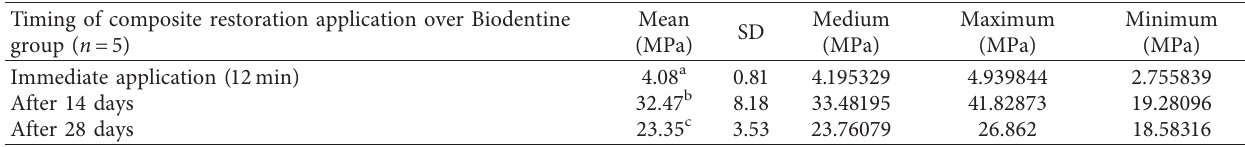
Table 2: The mean shear bond strength in MPa, standard deviation (SD), medium, maximum, and minimum for all tested groups. Timing of composite restoration application over Biodentine group ( n �